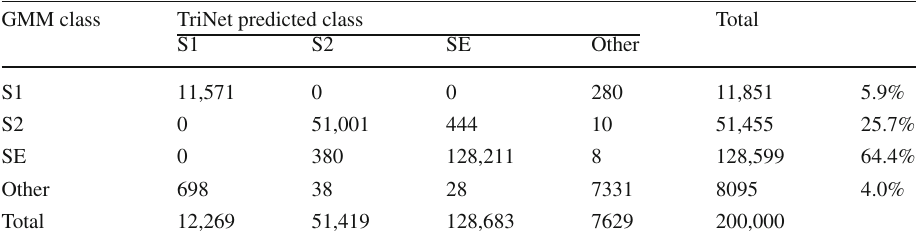
left: pulses classified as S1. Top right: pulses classified as S2. Bottom- right: pulses classified as SE. Bottom-left: distribution of the remaining pulses, i.e., classified as Other